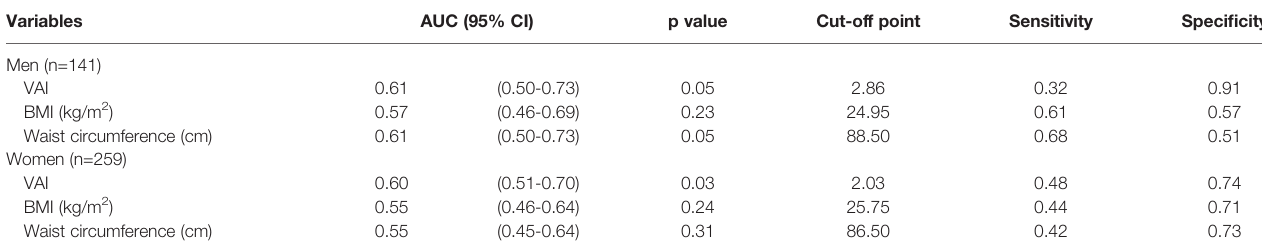
TABLE 4 | The areas under ROC curve (AUC), sensitivity, and speci fi city by the optimized cut-off points for obesity indices in predicting CKD according to gender.